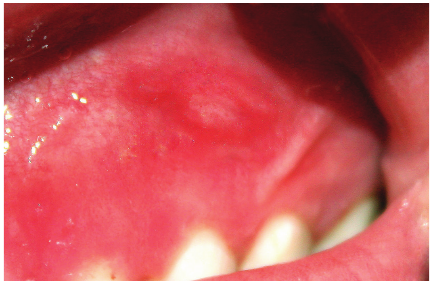
Figure 2: A demarcated area of mucosal erythema involving the left anterior maxillary alveolar mucosa.